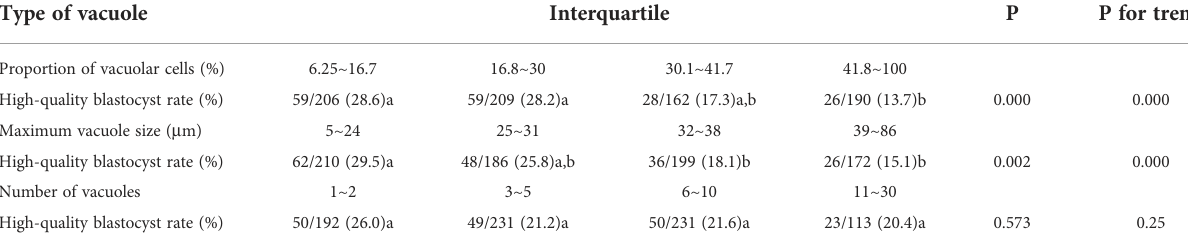
TABLE 3 Relationship between different vacuole types and blastocyst quality.